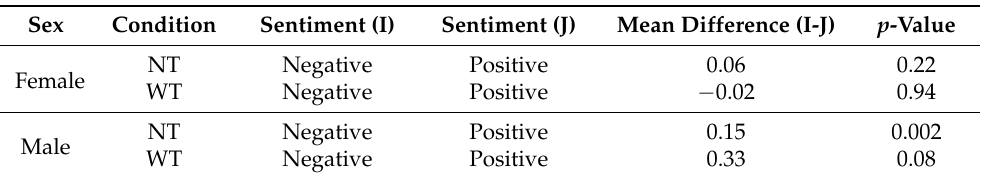
Table 8. Sex Comparison Between Physiological Arousal Change in Positive and Negative Utterances by Touch